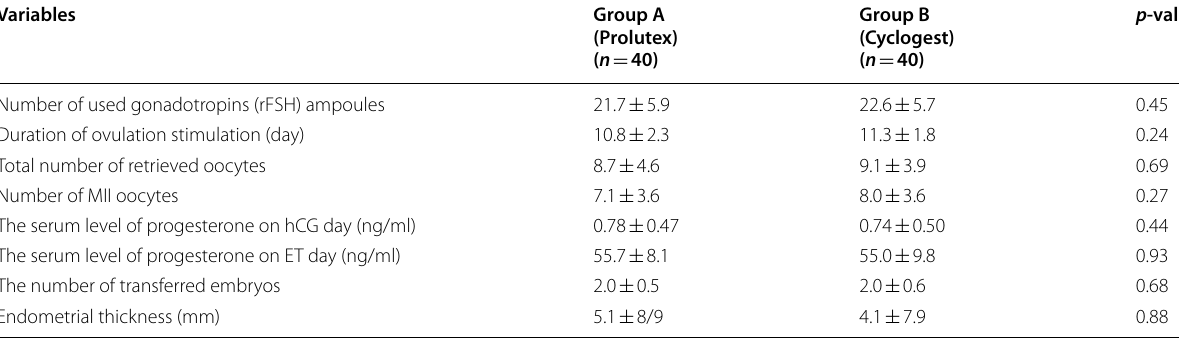
rFSH , recombinant follicle-stimulating hormone; hCG , human chorionic gonadotropin; ET , embryo transfer. The data are presented as mean ( P -value less than 0.05, there was a significant difference between groups